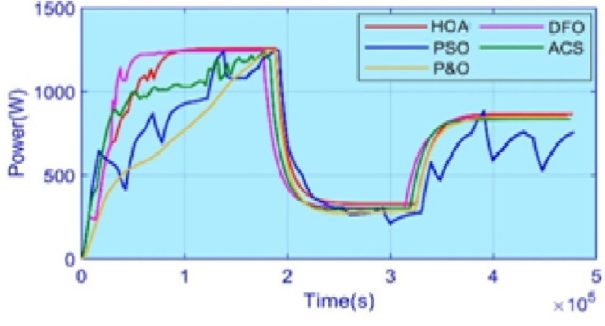
Figure 12. Comparison of HOA power for Case 1 .